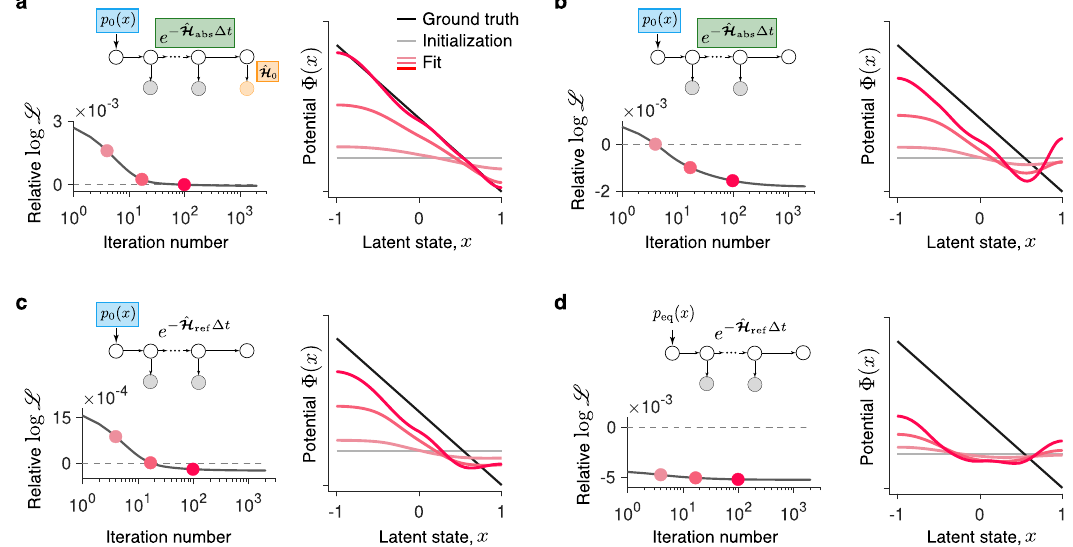
Fig. 3 Contribution of non-stationary components to the accurate inference of latent Langevin dynamics. The spike data are generated from the Langevin dynamics with a linear potential and absorbing boundaries (Fig. 2b). a The inference incorporates the non-equilibrium initial state distribution p x ), absorbing boundary conditions, and the absorption operator (graphical diagram, inset in the left panel). When the likelihood of the fi tted model (cid:5) (cid:6) 0 ( = log L approaches the likelihood of the ground-truth model (left panel, the relative log-likelihood is log L gt (cid:2) log L gt ), the inferred potential shape closely matches the ground truth (right panel, colors correspond to the iterations marked with dots on the left panel). b Same as a , but omitting the absorption operator in the inference. The relative log-likelihood is with respect to the likelihood for the ground-truth potential, with the absorption operator omitted in the likelihood calculation for both the ground-truth and fi tted potentials. c Same as b , but replacing the absorbing with re fl ecting boundary conditions in the inference and in the likelihood calculation for both the fi tted and ground-truth potentials. d Same as c , but replacing p 0 ( x ) with the equilibrium density p eq ( x ) in the inference and in the likelihood calculation for both the fi tted and ground-truth potentials. Omitting any of the non- stationary components results in artifacts in the inferred